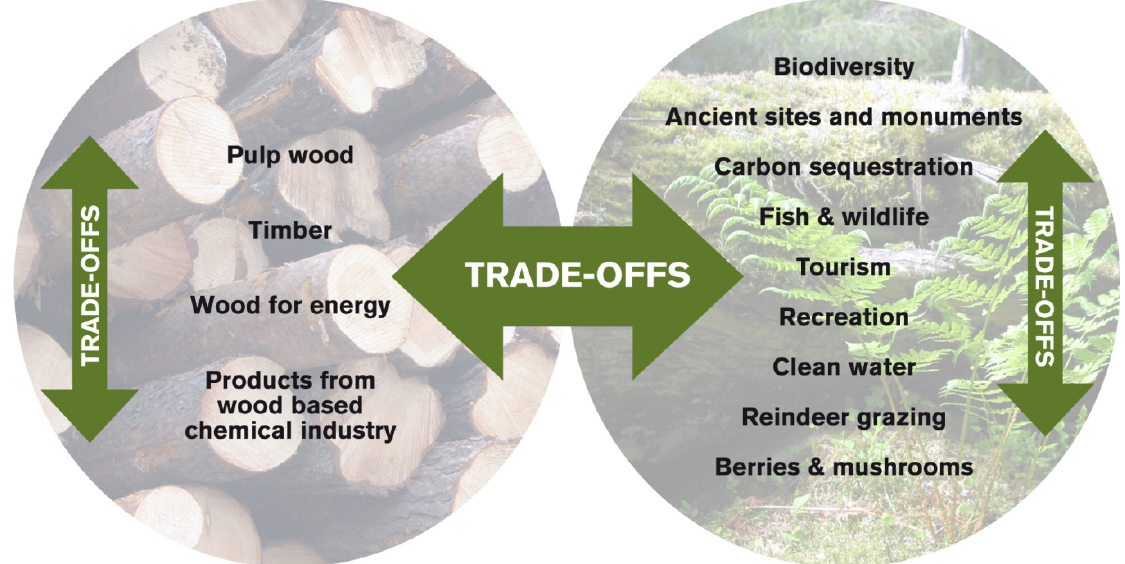
Figure 1. Schematic description of trade-offs between and within timber products and non-timber products in Swedish boreal